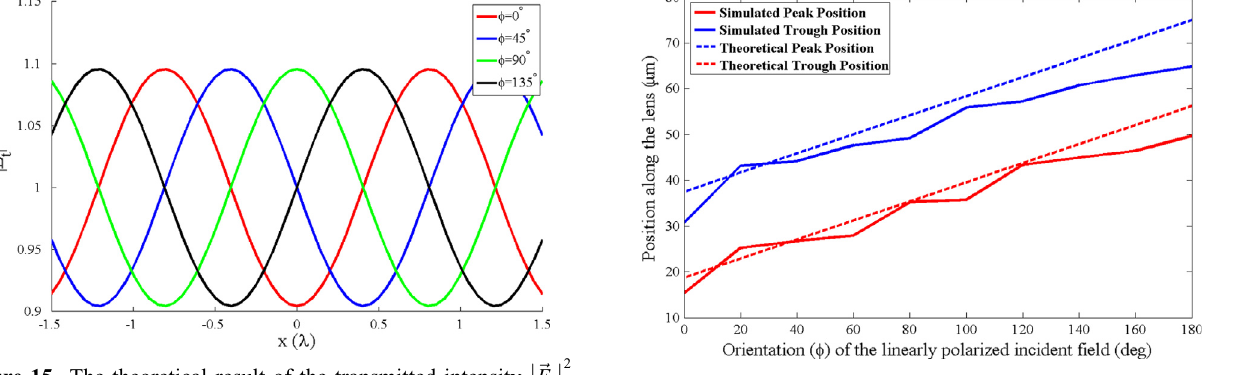
Figure 17. Theoretical and simulated peak and trough positions along the lens with respect to the orientation angle of a linearly polarized incident light.